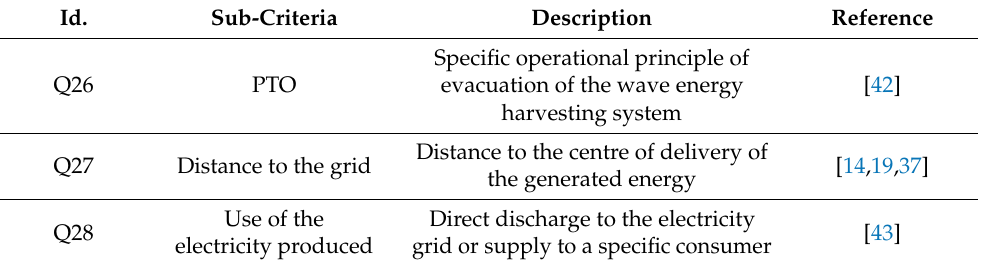
Table A7. Block 6: Influence of the energy disposal system. Q26 to Q28. Id.